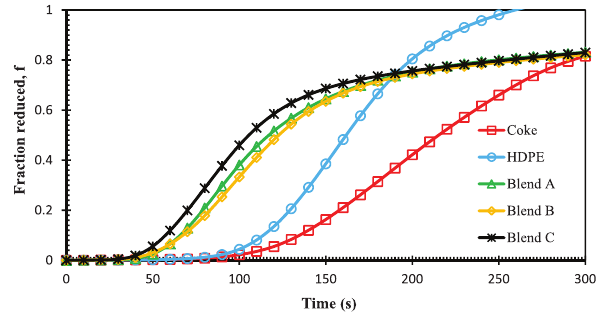
Fig. 11: Pre-reduction behavior of manganese oxide during reduction by various carbonaceous blends at 1150 °C